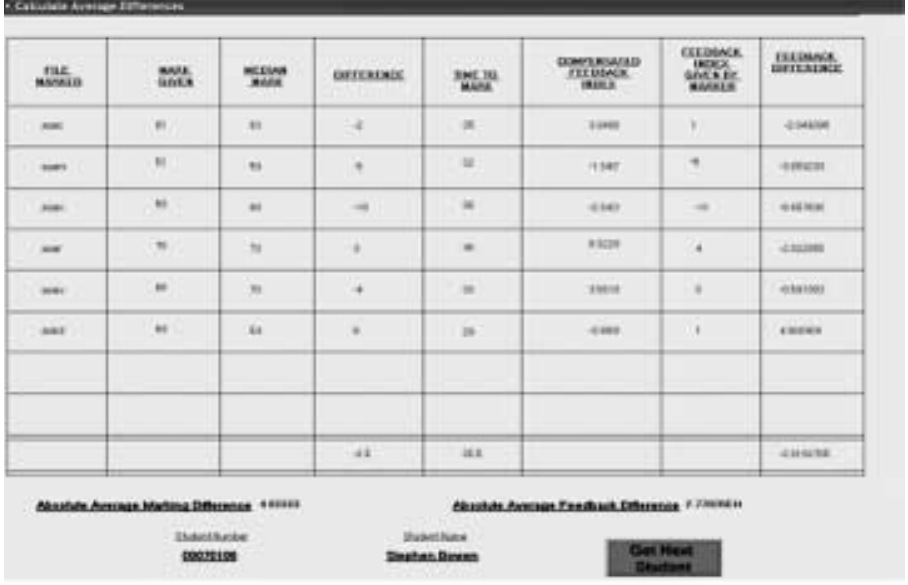
Figure 4. Quantification of differences in NIA student